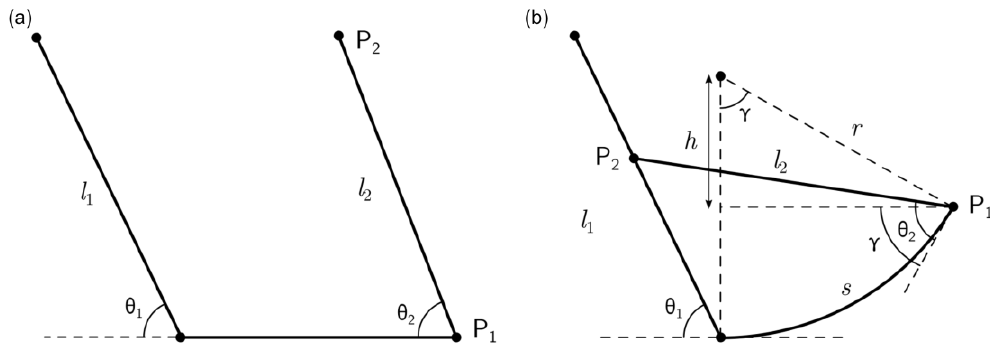
Figure 2. Schematic of the simplified fish scale model shown for ( a ) a neutral state and ( b ) when scales first interact.